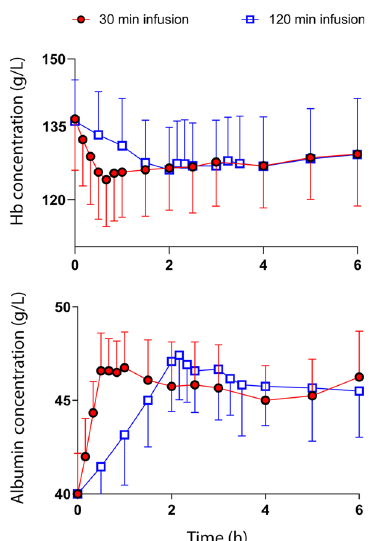
Fig. 2 Raw data. A The blood hemoglobin and B plasma albumin concentration during and after infusion of 3 ml/kg of 20% albumin over 30 min and 120 min in volunteers. Data are the mean